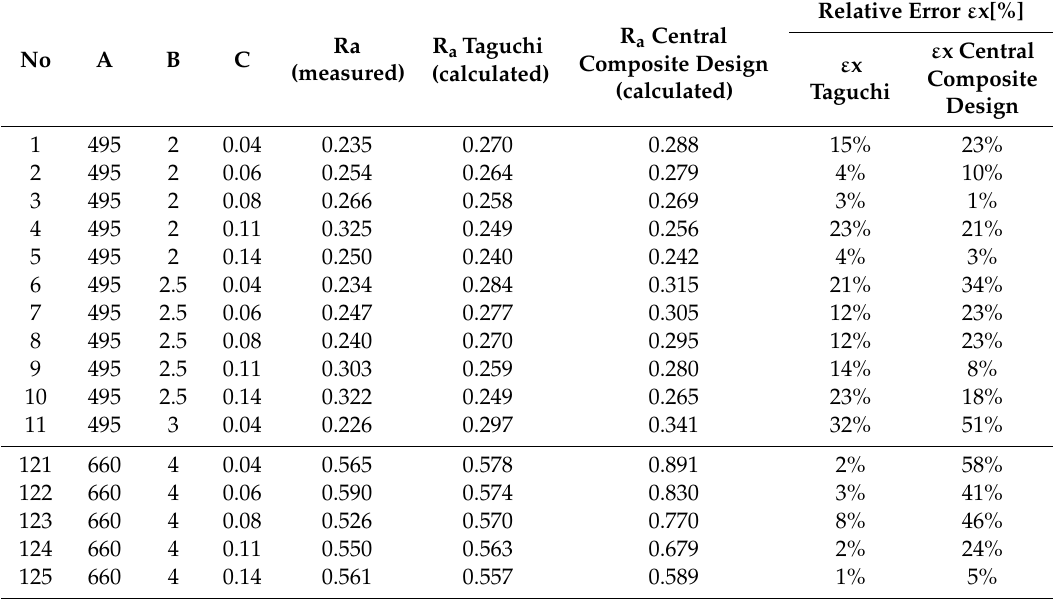
Figure 8. Normal probability plot—response in Ra (central composite design (CCD) case)).